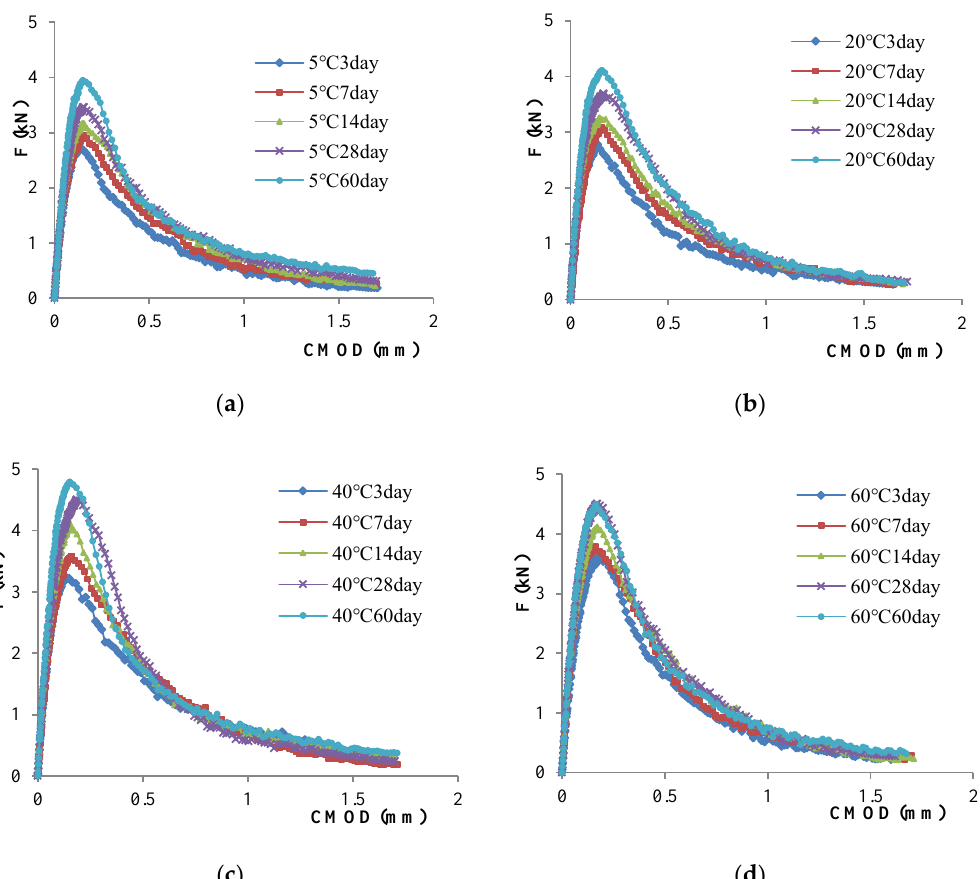
Figure 3. Load-crack mouth opening displacement (CMOD) curves under dry environments with different temperatures: ( a ) at 5 °C; ( b ) at 20 °C; ( c ) at 40 °C; ( d ) at 60 °C.